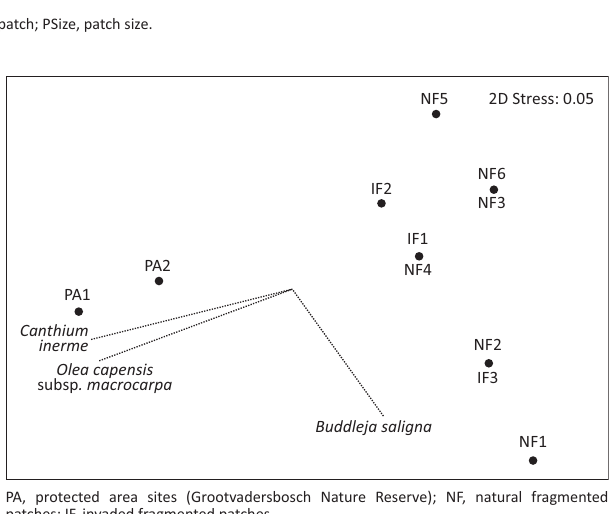
FIGURE 3: Non-metric multidimensional scaling ordination depicting the observed tree community settling activity of Charaxes xiphares occidentalis across all study sites. The indicated tree species had the strongest influence ( r > 0.8) in structuring the observed dissimilarity in tree community settling pattern across the study